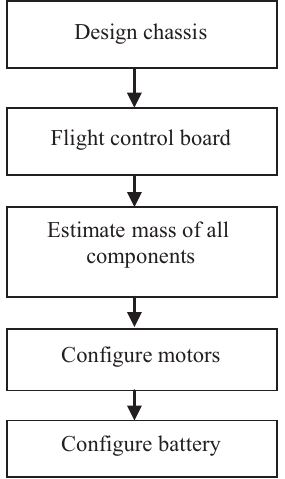
Fig. 2. Design cycle of coaxial rotor helicopter